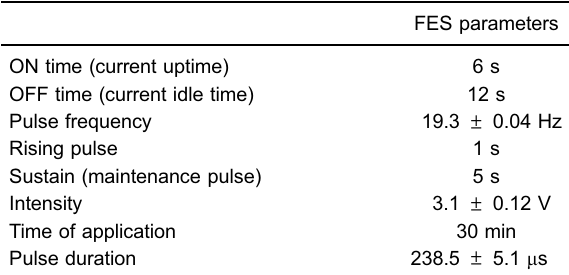
Table 1. Parameters for application of functional electrical stimulation (FES).